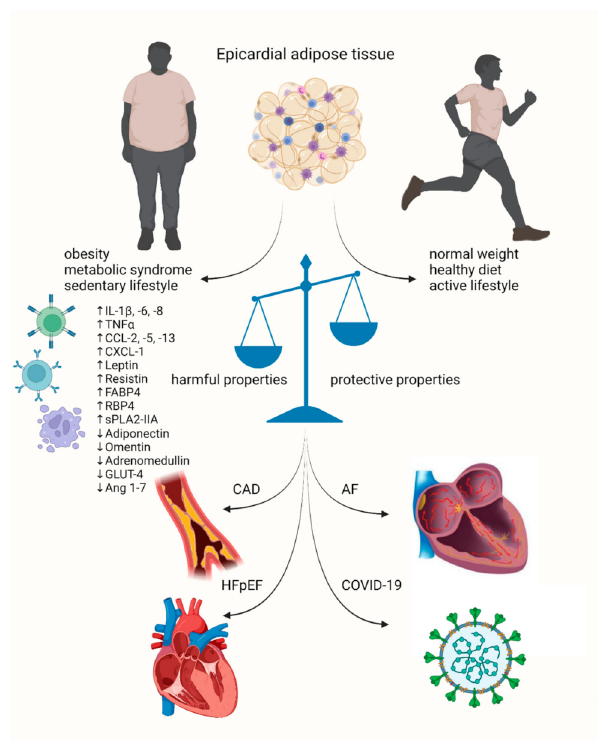
Figure 2. The role of epicardial adipose tissue in the development of cardiovascular diseases and car- diovascular complications in the course of COVID-19. AF—atrial fibrillation; Ang 1–7—angiotensin 1–7; CAD—coronary artery disease; CCL-2, -5, -13—chemokine ligand-2, -5, -13; CXCL-1— chemokine ligand 1; FABP4—fatty acid binding protein 4; GLUT-4—glucose transporter type 4; HFpEF—heart failure with preserved ejection fraction; IL-1 β , -6, -8—interleukin-1 β , -6, -8; RBP4— retinol binding protein 4; sPLA2-IIA—secretory phospholipase A2; TNF α —tumor necrosis factor α